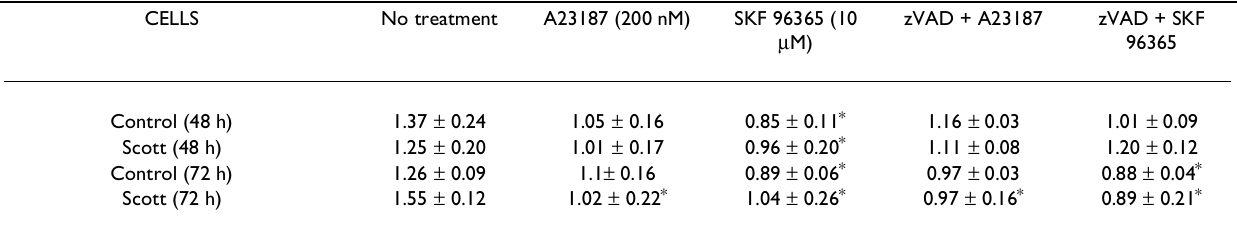
Table 2: Changes of mitochondrial membrane potential, assessed by flow cytometry using JC-1 red/green fluorescence ratio in in control and Scott cells after 48 or 72 h of apoptosis induction by calcium ionophore A23187 (200 nM) or SKF 96365 (10 µ M) in the absence and presence of the caspase inhibitor z-VAD.fmk (50 µ M). Values are the mean ± SEM of 4 independent experiments.